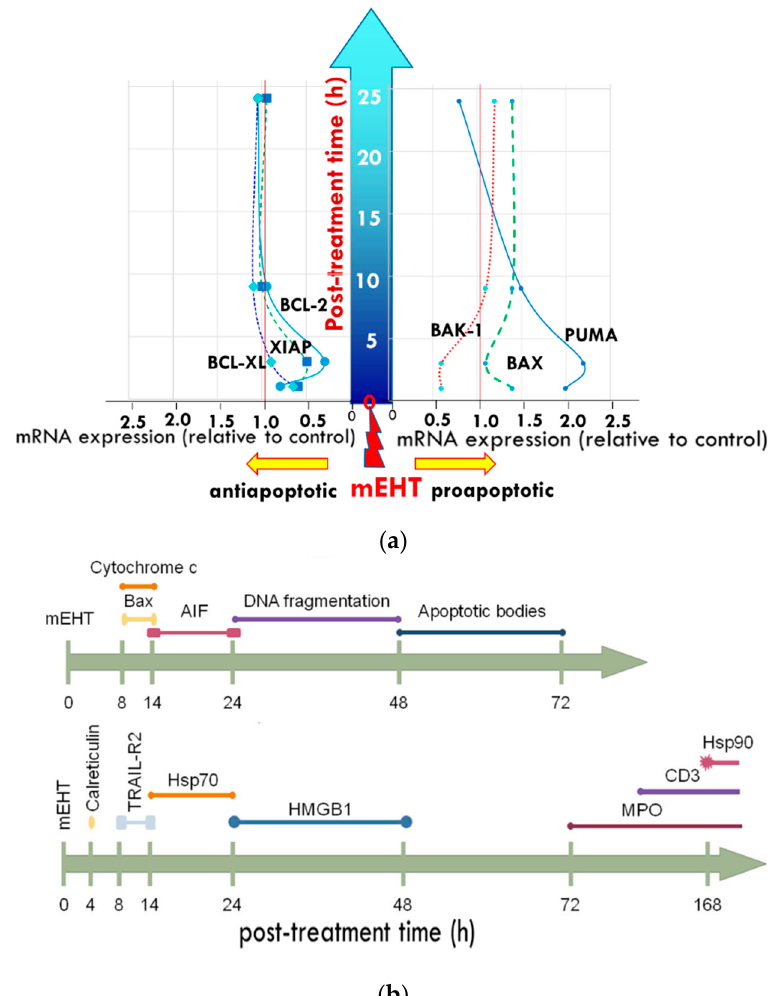
Figure 19. The time scale of the apoptotic processes: ( a ) development of pro-and anti-apoptotic proteins on the first day (24 h) post-treatment; ( b ) further developments with cellular reactions visible until the end of the apoptotic process (48 h post-treatment) and the immune reactions that follow three days after treatment.